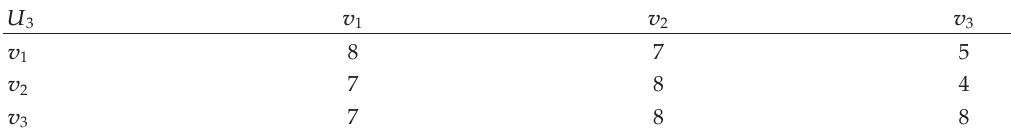
Table 9: Score table: U 3 -fuzzy soft multiset part of Row-sum (cid:5) r i (cid:6) Column-sum (cid:5) t i (cid:6) Score (cid:5) S i (cid:6) v 1 20 22 v 2 19 23 v 3 23 17